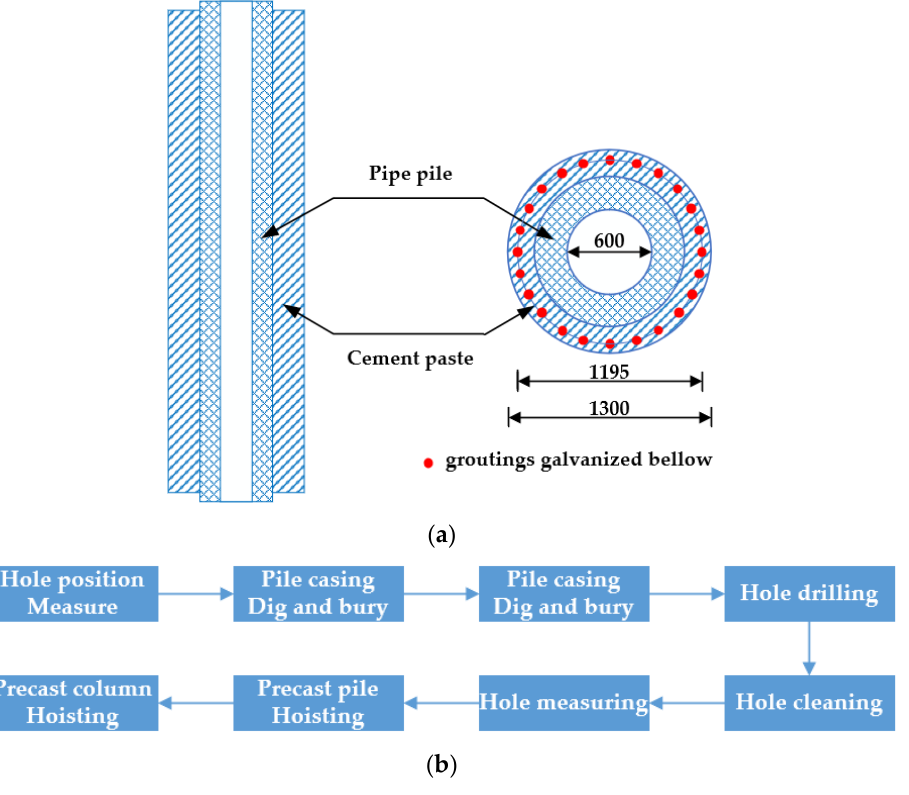
Figure 2. “Pile–Column Integration”: ( a ) schematic diagram of composite embedded pile method (unit: mm) and ( b ) construction process.